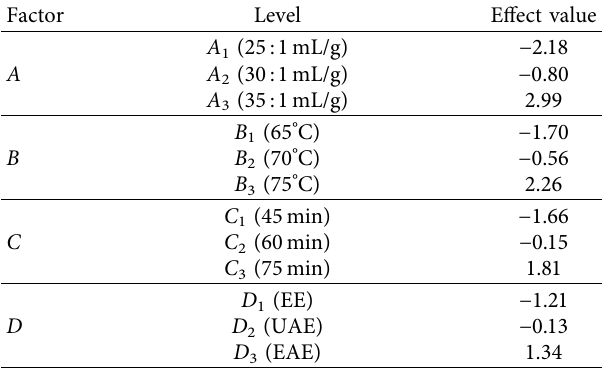
Table 5: Effect values of factors and levels for CFs